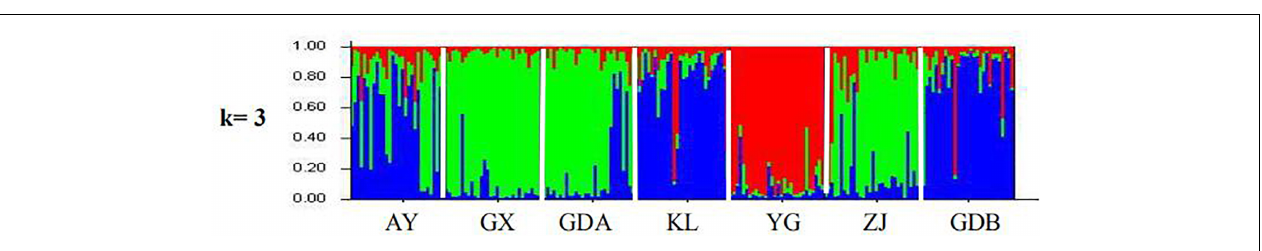
FIGURE 4 | Principal coordinate analysis of all the individuals of M. rosenbergii based on dissimilarity matrix (1-Jaccard) between pairs of genotypes. Capital letter indicates the name of sample. PC, Principal coordinate.